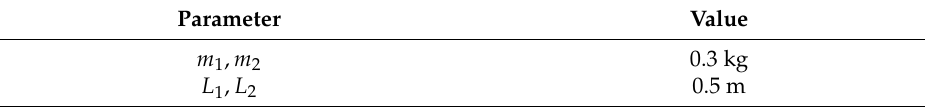
Table 2. Driven double pendulum